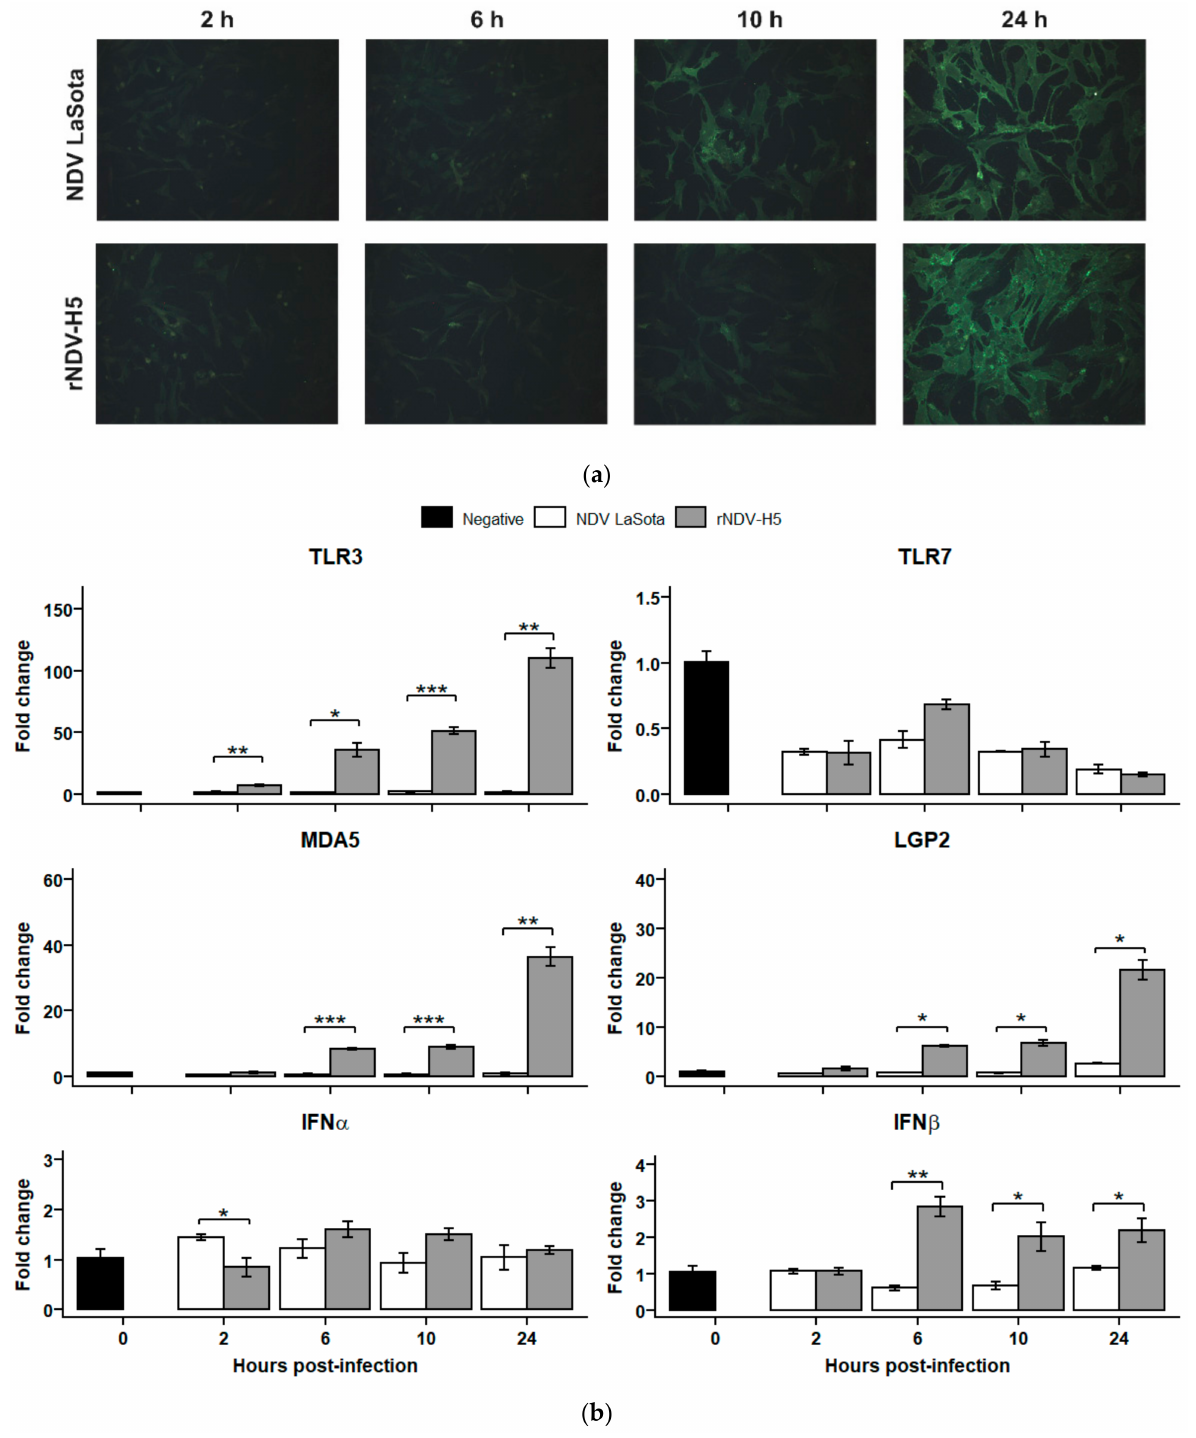
Figure 3. PRRs and type-I IFNs expression in NDV LaSota- and rNDV-H5-infected CEFs. ( a ) CEFs were infected with NDV LaSota and rNDV-H5 (MOI = 1) and observed by fluorescence microscopy using an anti-F antibody (IC3, IgG1) at 2, 6, 10, and 24 hpi. ( b ) Relative expression of TLR3, TLR7, MDA5, LGP2, IFN α , and IFN β was determined in CEFs infected with NDV LaSota and rNDV-H5 (MOI = 1) at 2, 6, 10, and 24 hpi. The data were normalized to HMBS and RPLP0 expression, calculated according to the 2 - ∆∆ CT method, and presented ± standard error of the mean. * p < 0.05, ** p < 0.01, *** p <